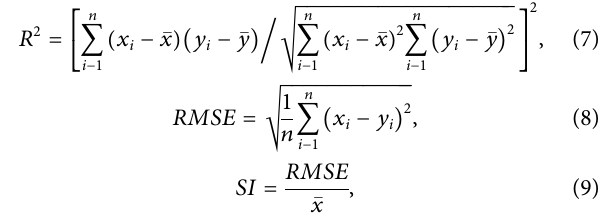
Figure 3 : The calculated R 2 for T, Q, and CM data was 0.019, 0.437, and 0.460, respectively, indicating that the CM, Q, and T ranged from highest to lowest correlation. From the results of the regression correlation test, it can be expected that T is the least effective input data in predicting SL, and CM is the most effective input data in predicting